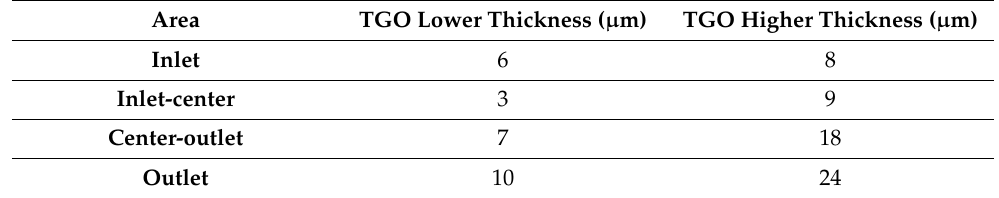
Table 4. TGO thicknesses measured at the fuel